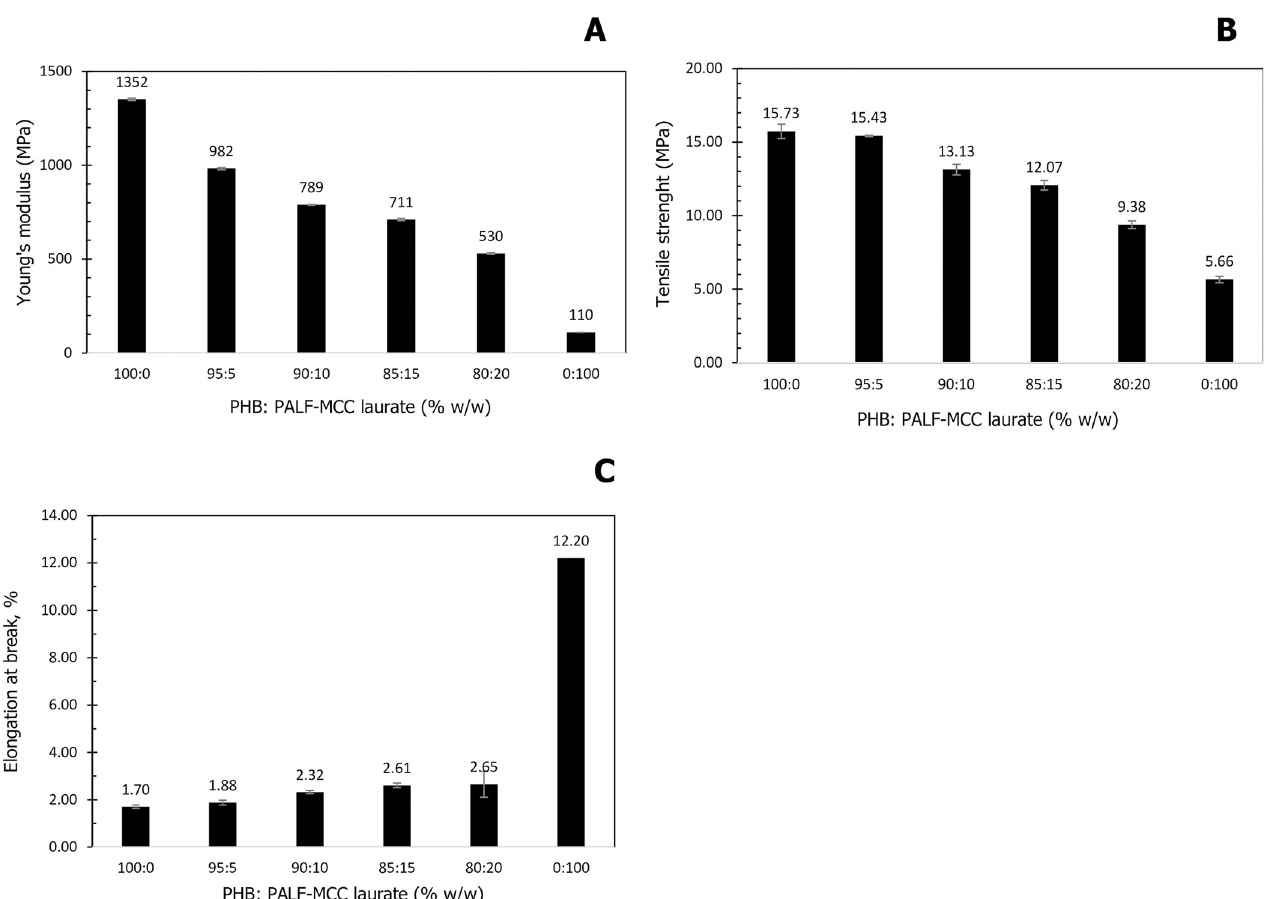
Fig 7. Effect of esterified PALF-MCC laurate addition on mechanical properties: (A) Young’s modulus, (B) tensile strength and (C) % elongation at break of PHB/esterified PALF-MCC laurate films.